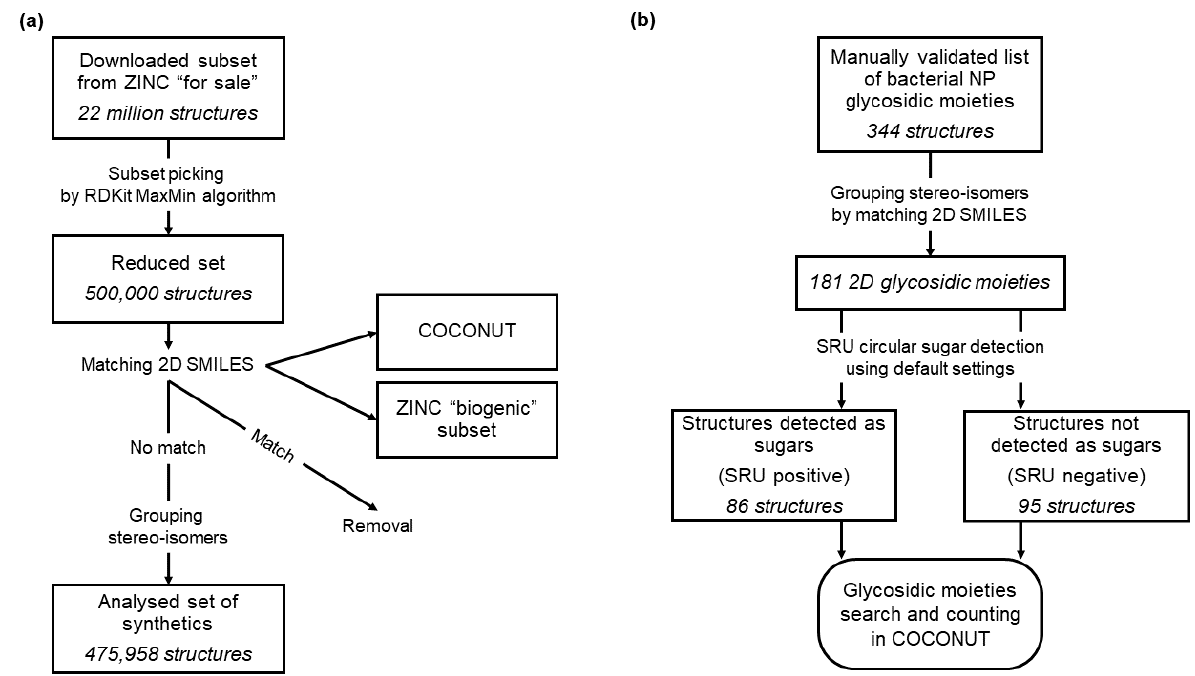
Figure 2. Data curation workflows. ( a ) Curation of synthetic molecules dataset from ZINC “for sale”. A total of 22 million molecules were downloaded from the ZINC “for sale” dataset and a diverse subset of 500,000 structures curated using the RDKit MaxMin algorithm. In the second step, all molecules matching structures in the ZINC “biogenic” subset or COCONUT were removed and stereo-isomers grouped. ( b ) Curation of glycosidic moieties of bacterial NP dataset. The manually curated dataset of glycosidic moieties of bacterial natural products (NPs) was first grouped for stereoisomers, resulting in 181 distinct structures. These were then categorised into two sets based on their detectability using the Sugar Removal Utility (SRU) default settings. With both sets, a substructure search in COCONUT was performed.